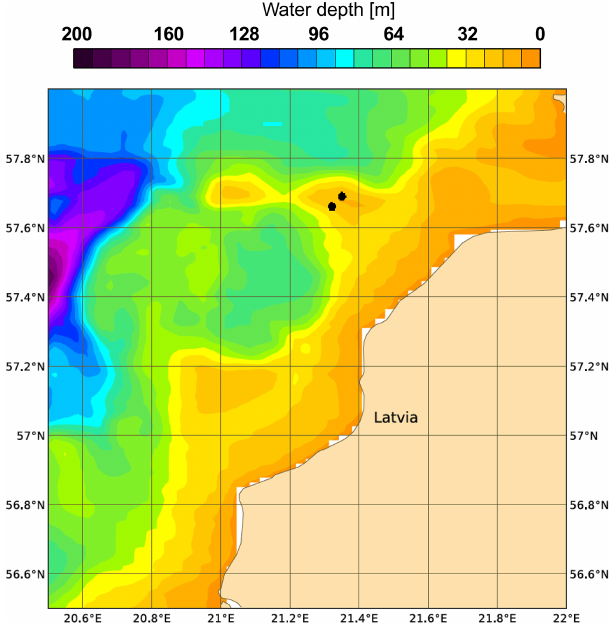
Figure 5. Bathymetry [m] of the subregion for which the model re- sults are presented. Black dots indicate the locations of two selected grid cells for later